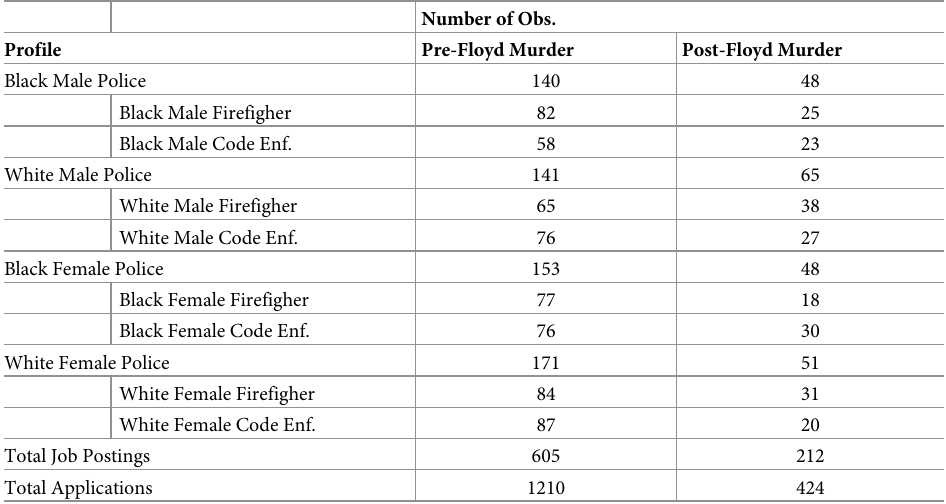
Table 1. Number of observations by time period, applicant race, gender, and prior profession. Number of